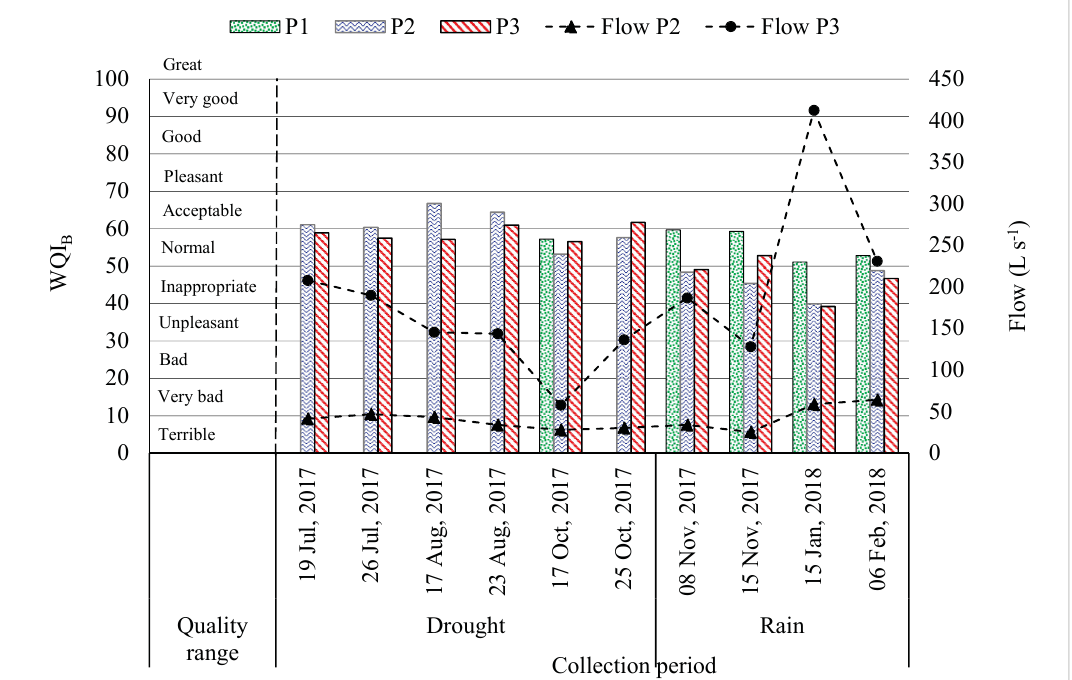
Figure 2: Values of the WQI B for the sampling points (P1, P2 and P3), as well as the flow for the Tamanduá stream at the time of sample